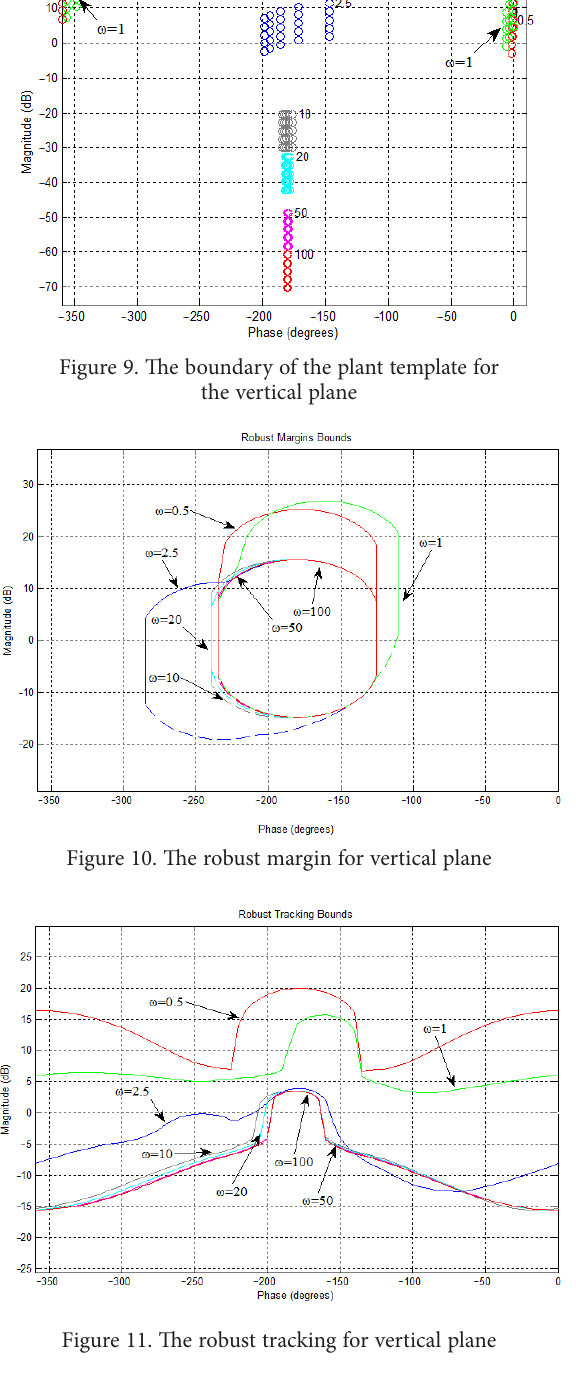
Figure 11. The robust tracking for vertical plane